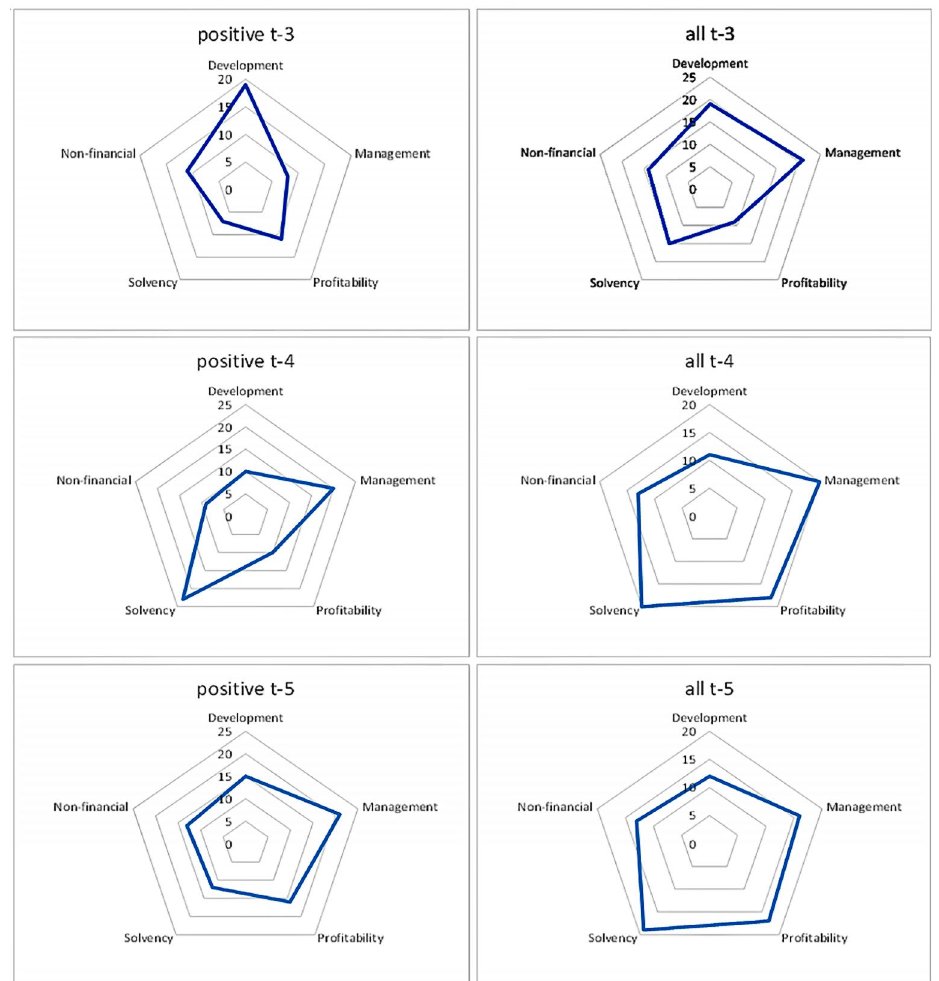
Figure 4. Comparison of indicator systems for positive and all